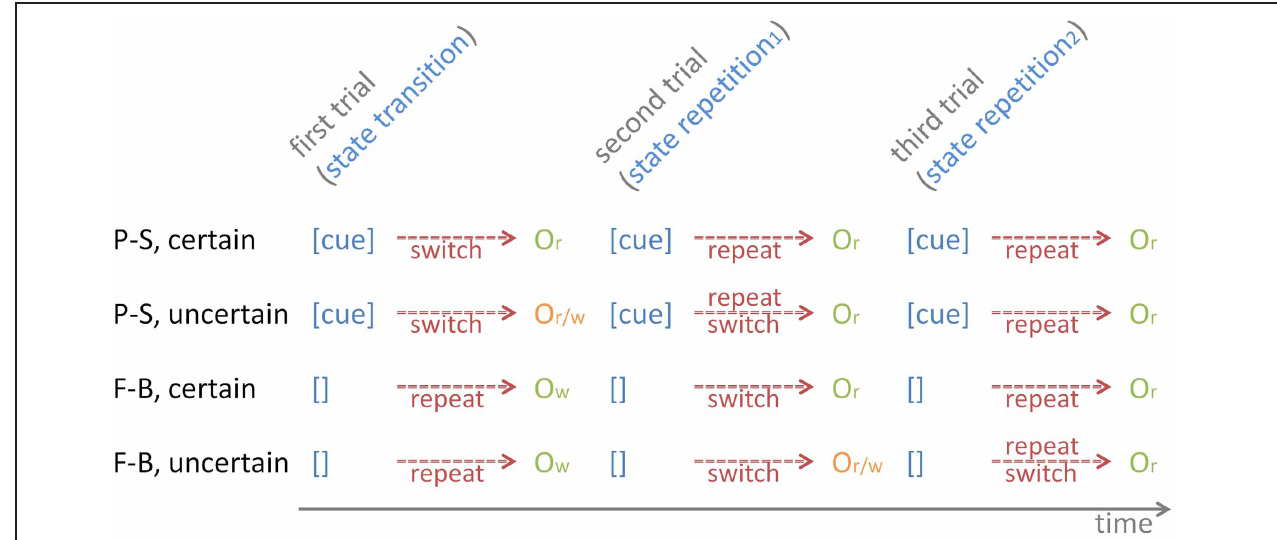
state-transition trials, and concomitantly to “wrong”-outcomes (O w ). Note the uncertainty of outcomes (“right” or “wrong,” O r / w ) on uncertain P-S state-transition trials and on uncertain F-B state-repetition 1 trials. Depending on the outcome valence, task-set repetitions or task-set switches are required on subsequent trials.